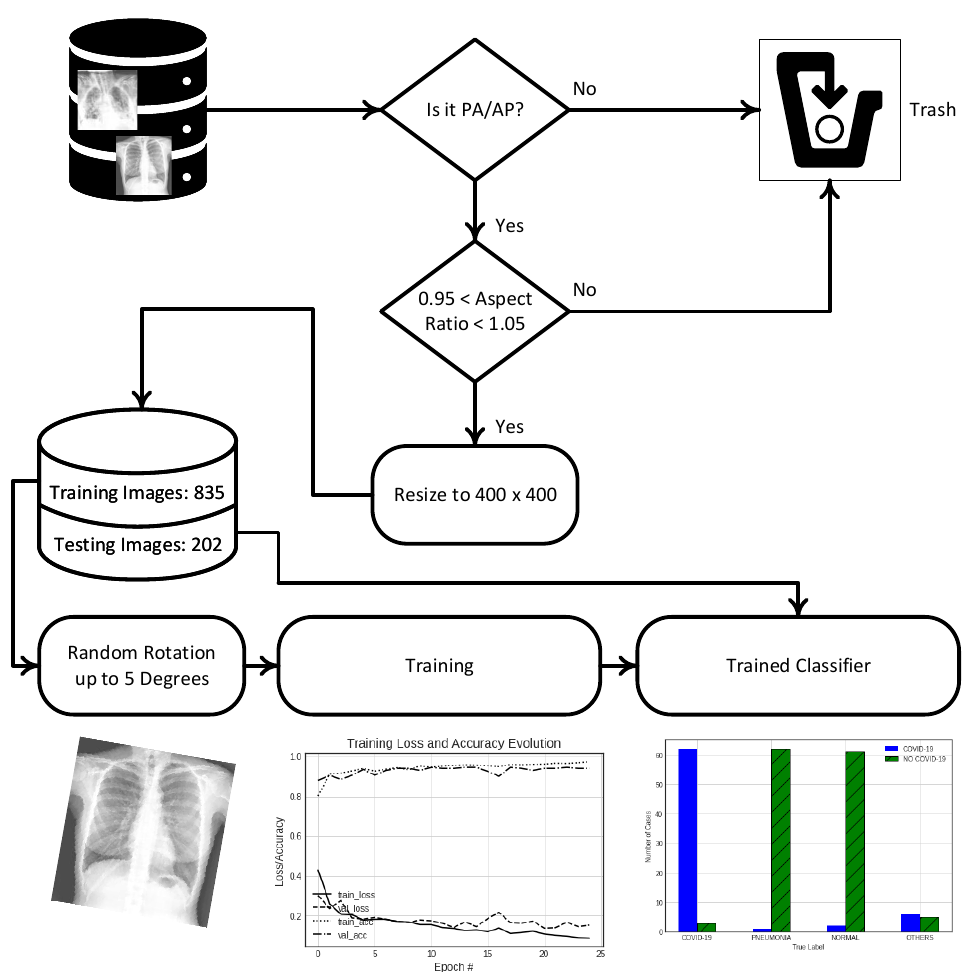
Figure 3. Schematic view of the entire process from data collection to